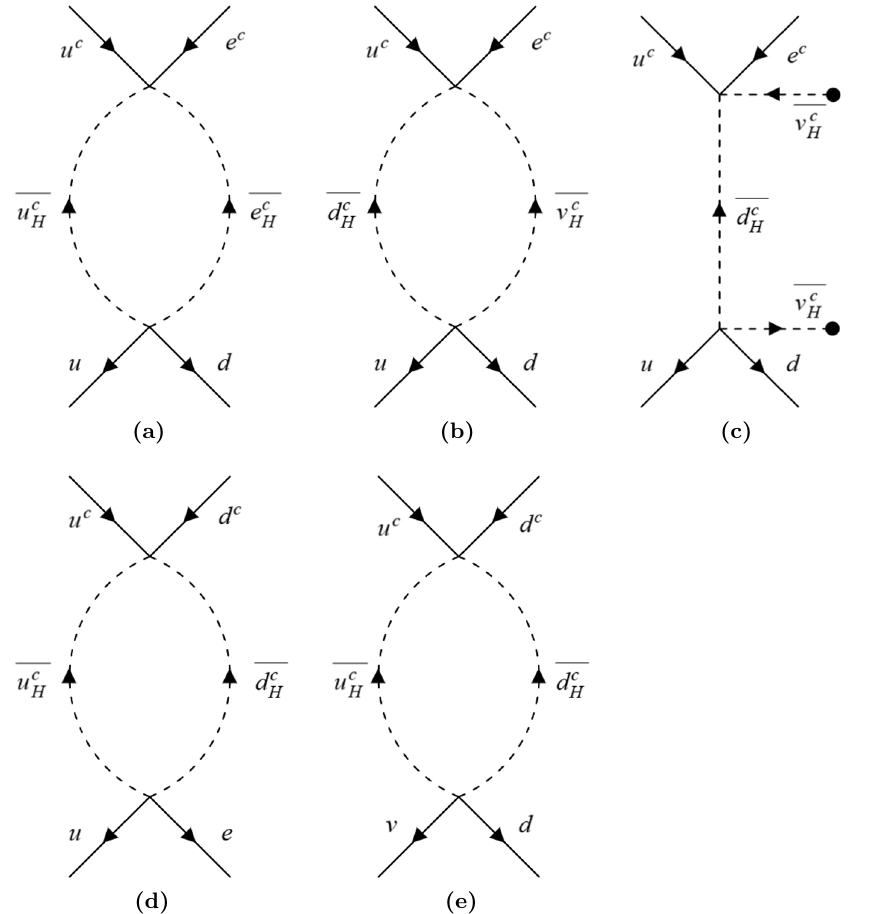
Figure 4. Dimension-six proton decay diagrams. Dashed lines represent bosons, solid lines repre- sent fermions, and dots represent the vevs. These are graphs between the B -violating superpotential coupling FFH c H c and the B -conserving superpotential coupling F c F c H c H c